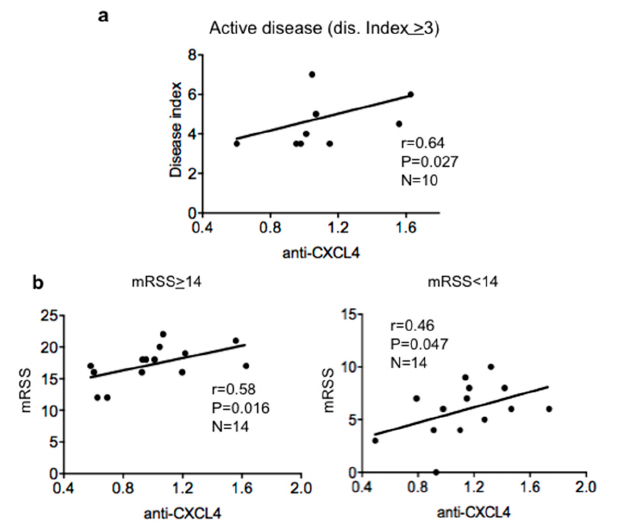
Figure 2. Anti-CXCL4 antibody reactivity can correlate with disease score (EScSGAI) and modified Rodnan skin score (mRSS) in active SSc. Sera of SSc1 (see Table S1)